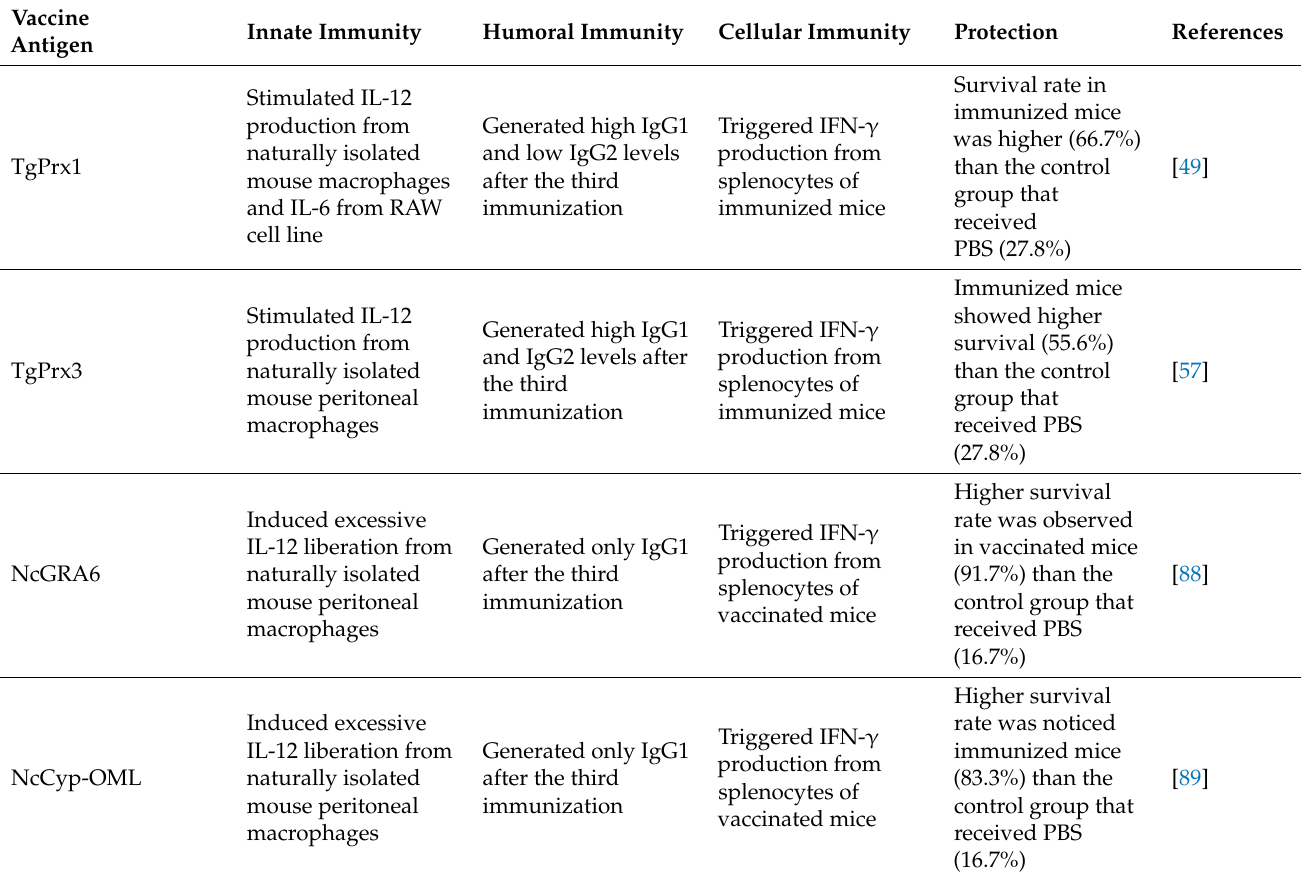
Table 3. Summary of previous reports on T. gondii and N. caninum vaccine antigens and their effects on